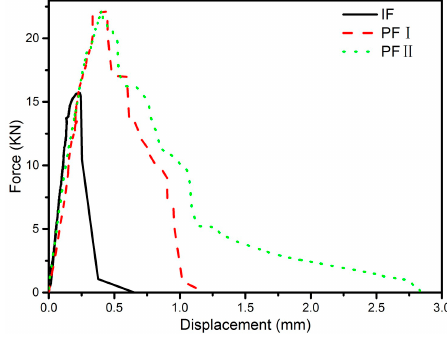
Figure 8. Typical force-displacement curve for three fracture modes.